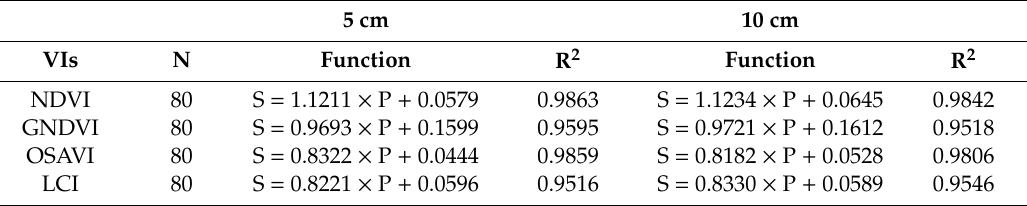
Table 4. Sequoia and P4M VI transformation functions derived by OLS regression of the data illustrated in Figure 9.